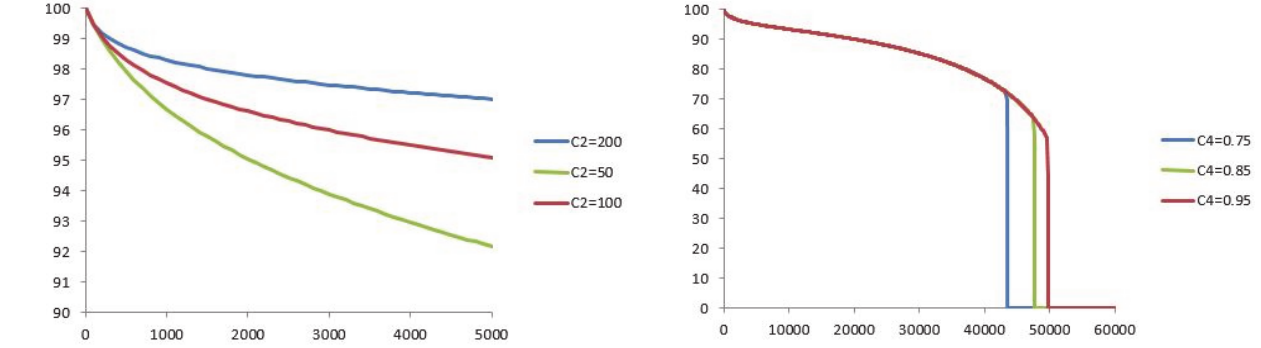
c (left) and c (right) on numerical stiffness 2,12 4,12